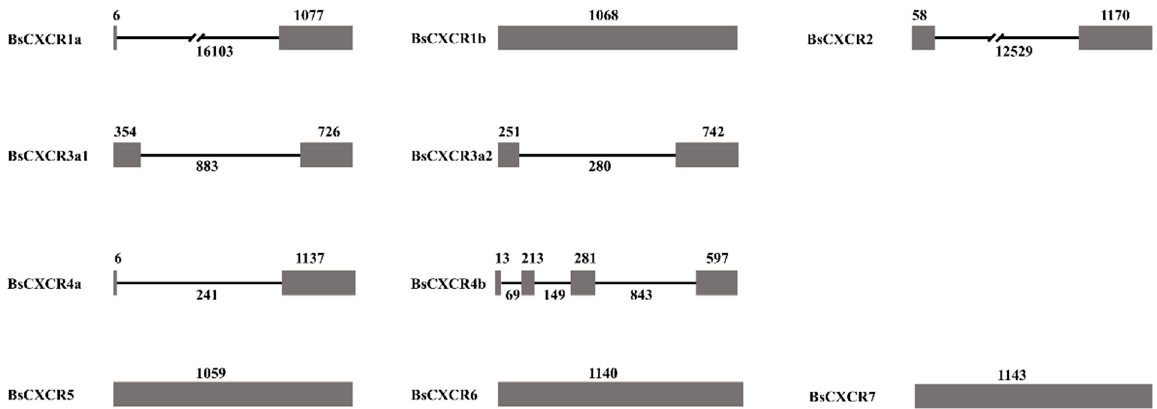
Figure 3. The exon-intron arrangements of BsCXCR genes. The grey boxes and black line represent the exons and introns, respectively. The number indicate their length.